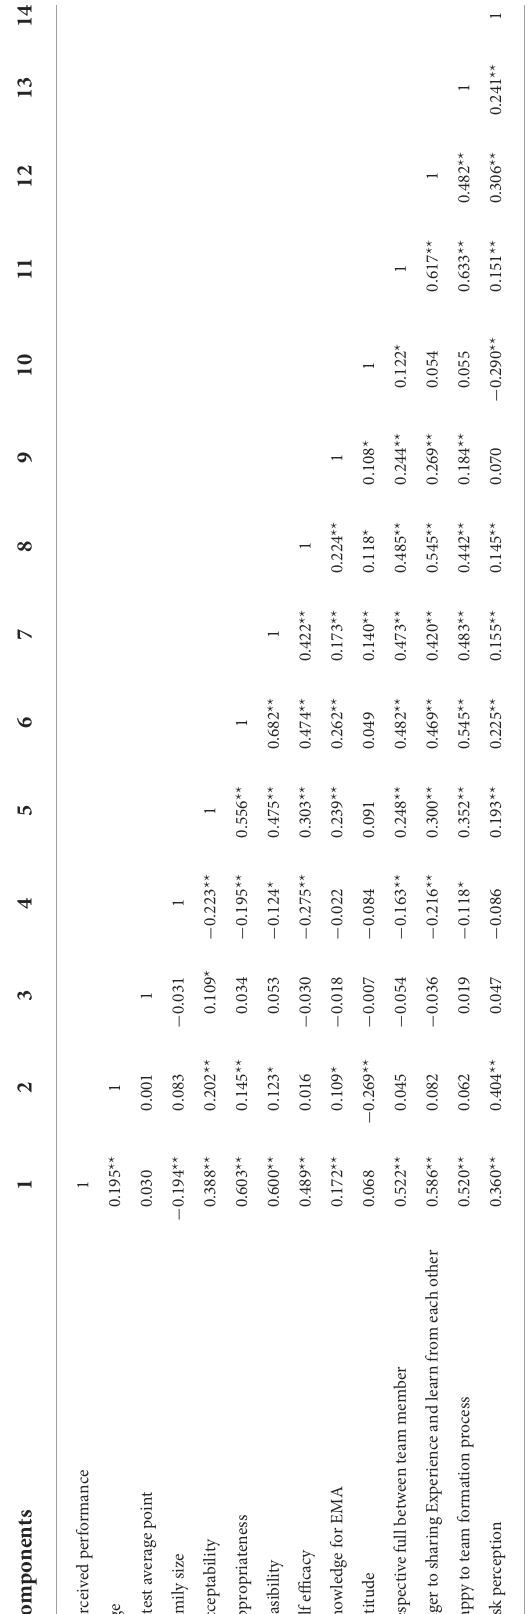
TABLE 7 Multivariable linear regression for perceived performance toward PLEA among Jimma zone trained peer educator